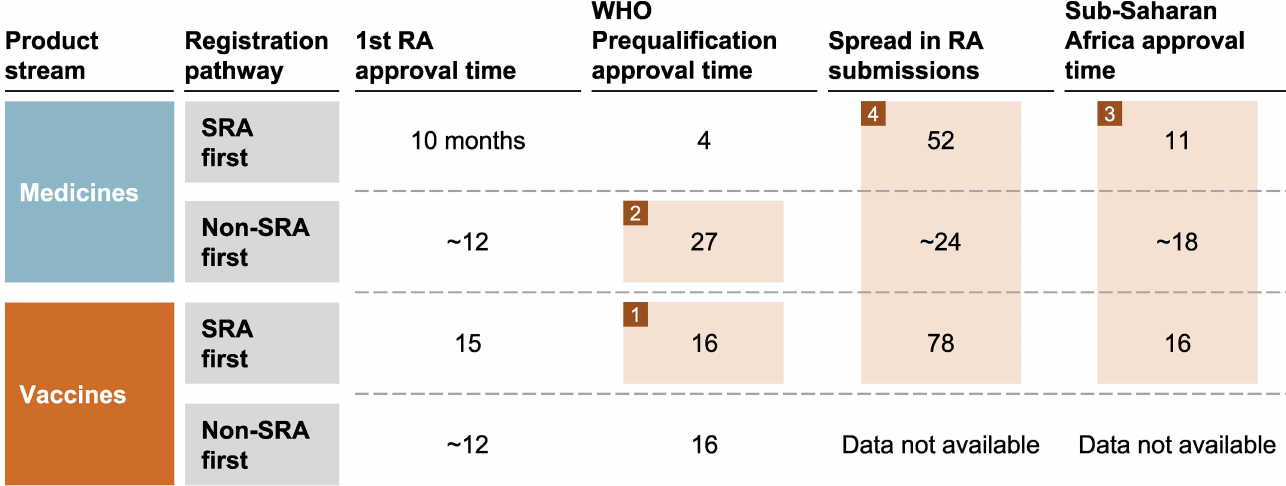
Fig 2. Registration Timelines (median in months) for Global Health Products (herein defined as products eligible for WHO Prequalification) Distributed in Sub-Saharan Africa (as of December2012).